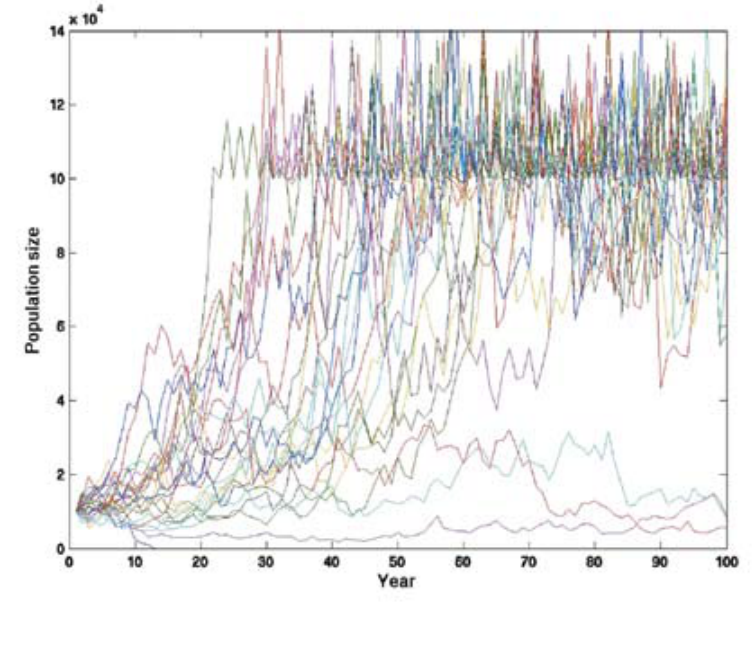
Fig. 11. Example of projection of a stochastic population model for the Baltic grey seal with 25 replications. The time frame here is 100 years, and the population is exposed to an an - nual hunt of 200 females. The initial female population size is 10,000, the annual rate of increase μ = 0.075 and the variance (σ2) is 0.033, the carrying capacity is 100,000